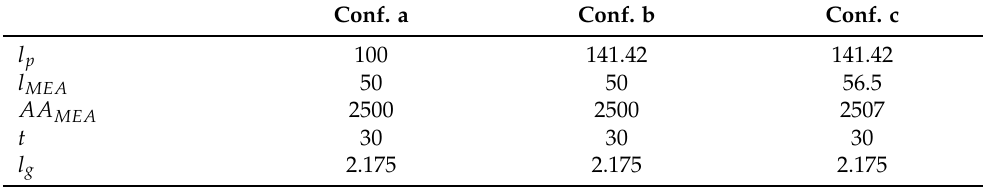
), and Von Mises stress ( σ max eq